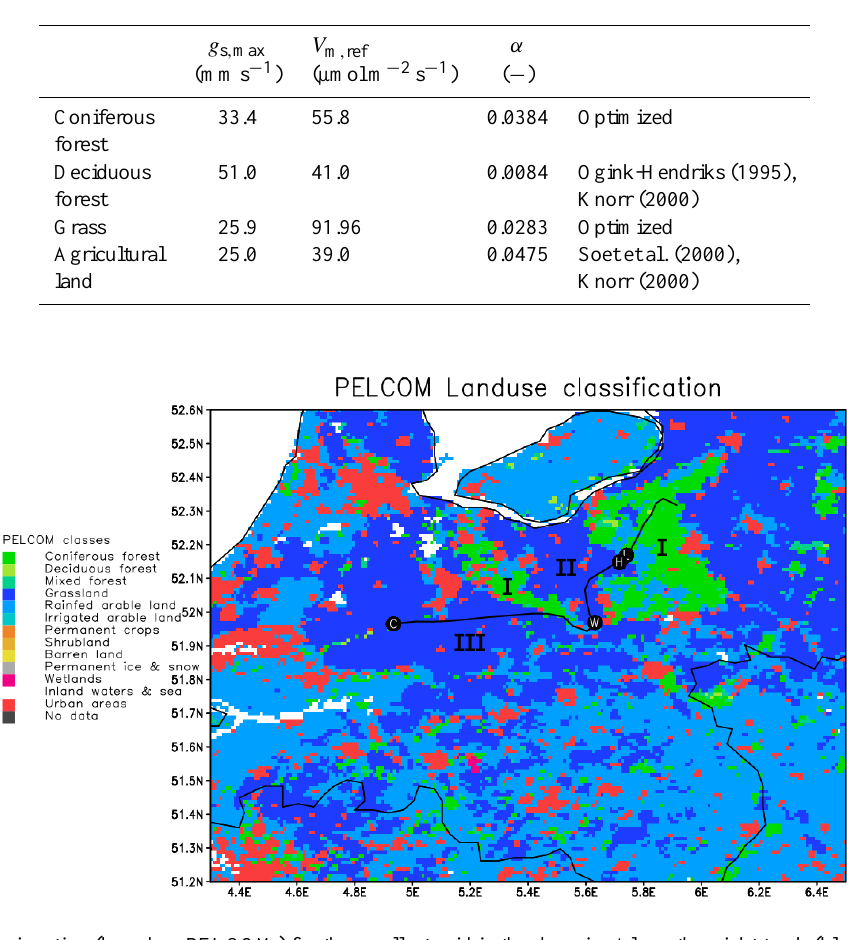
Fig. 3. Land cover classification (based on PELCOM) for the smallest grid in the domain. Along the flight track (black line) the location of the observational sites are also given: C – Cabauw; W – Wageningen; H – Harskamp; L – Loobos. The roman numbers correspond to the areas described in the